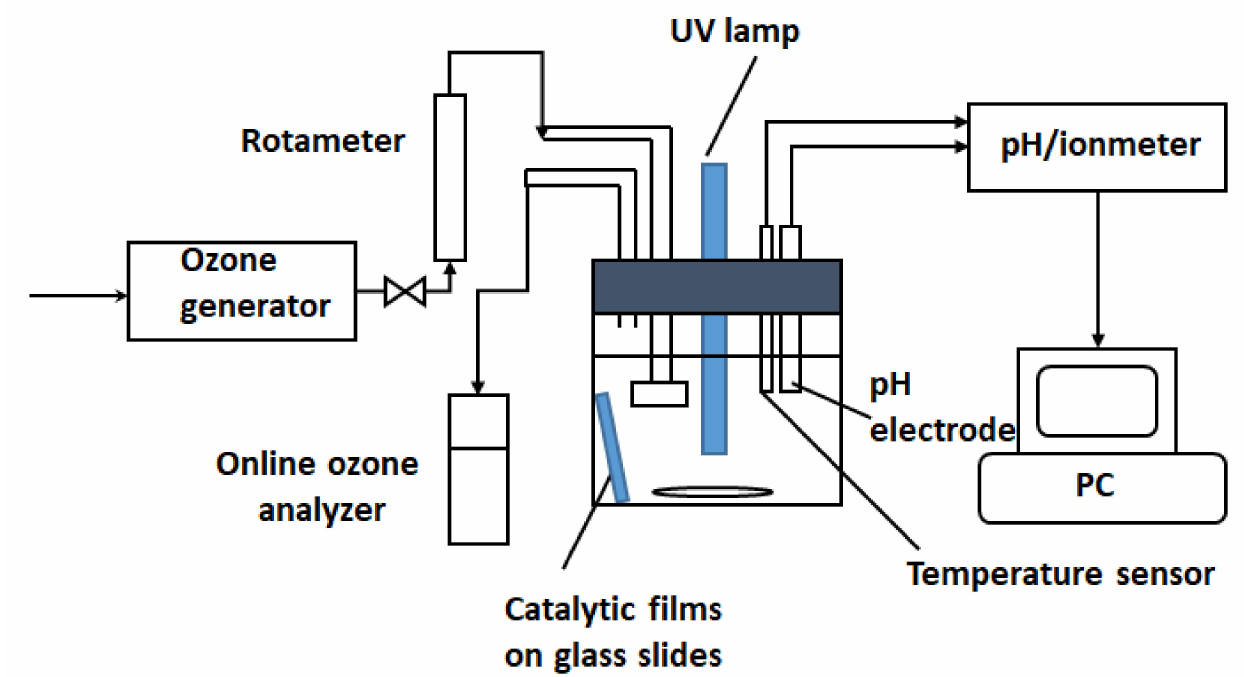
Figure 1. Experimental set-up for photocatalytic ozonation